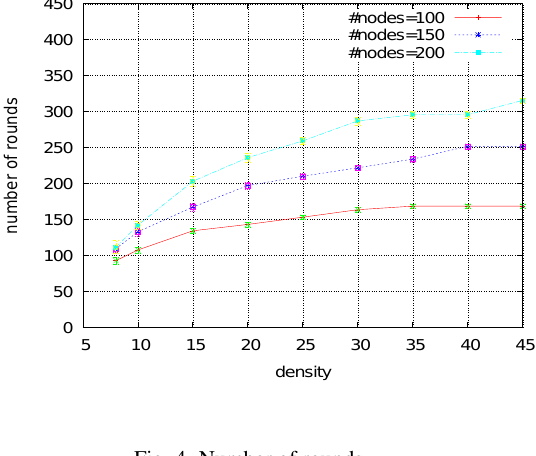
Fig. 4. Number of